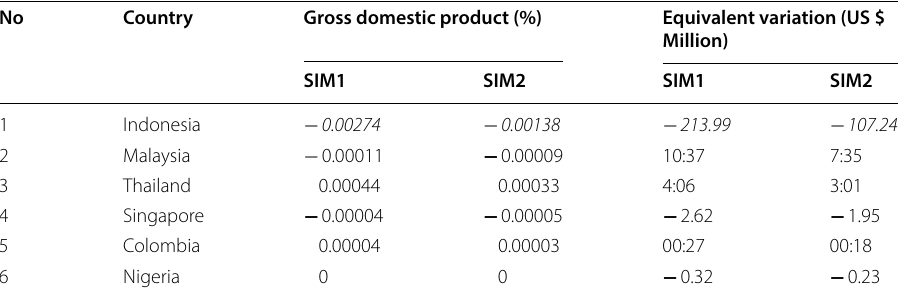
Table 2 Impact of palm oil exports’ stoppage to the European Union based on macroeconomic conditions of gross domestic product (GDP) and welfare level in Indonesia and other palm oil-producing